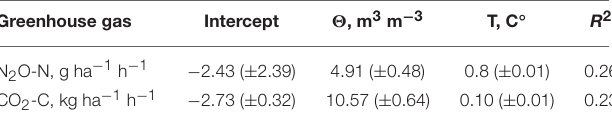
TABLE 4 | Regression model for effects of soil temperature and moisture on N 2 O and CO 2 flux † .